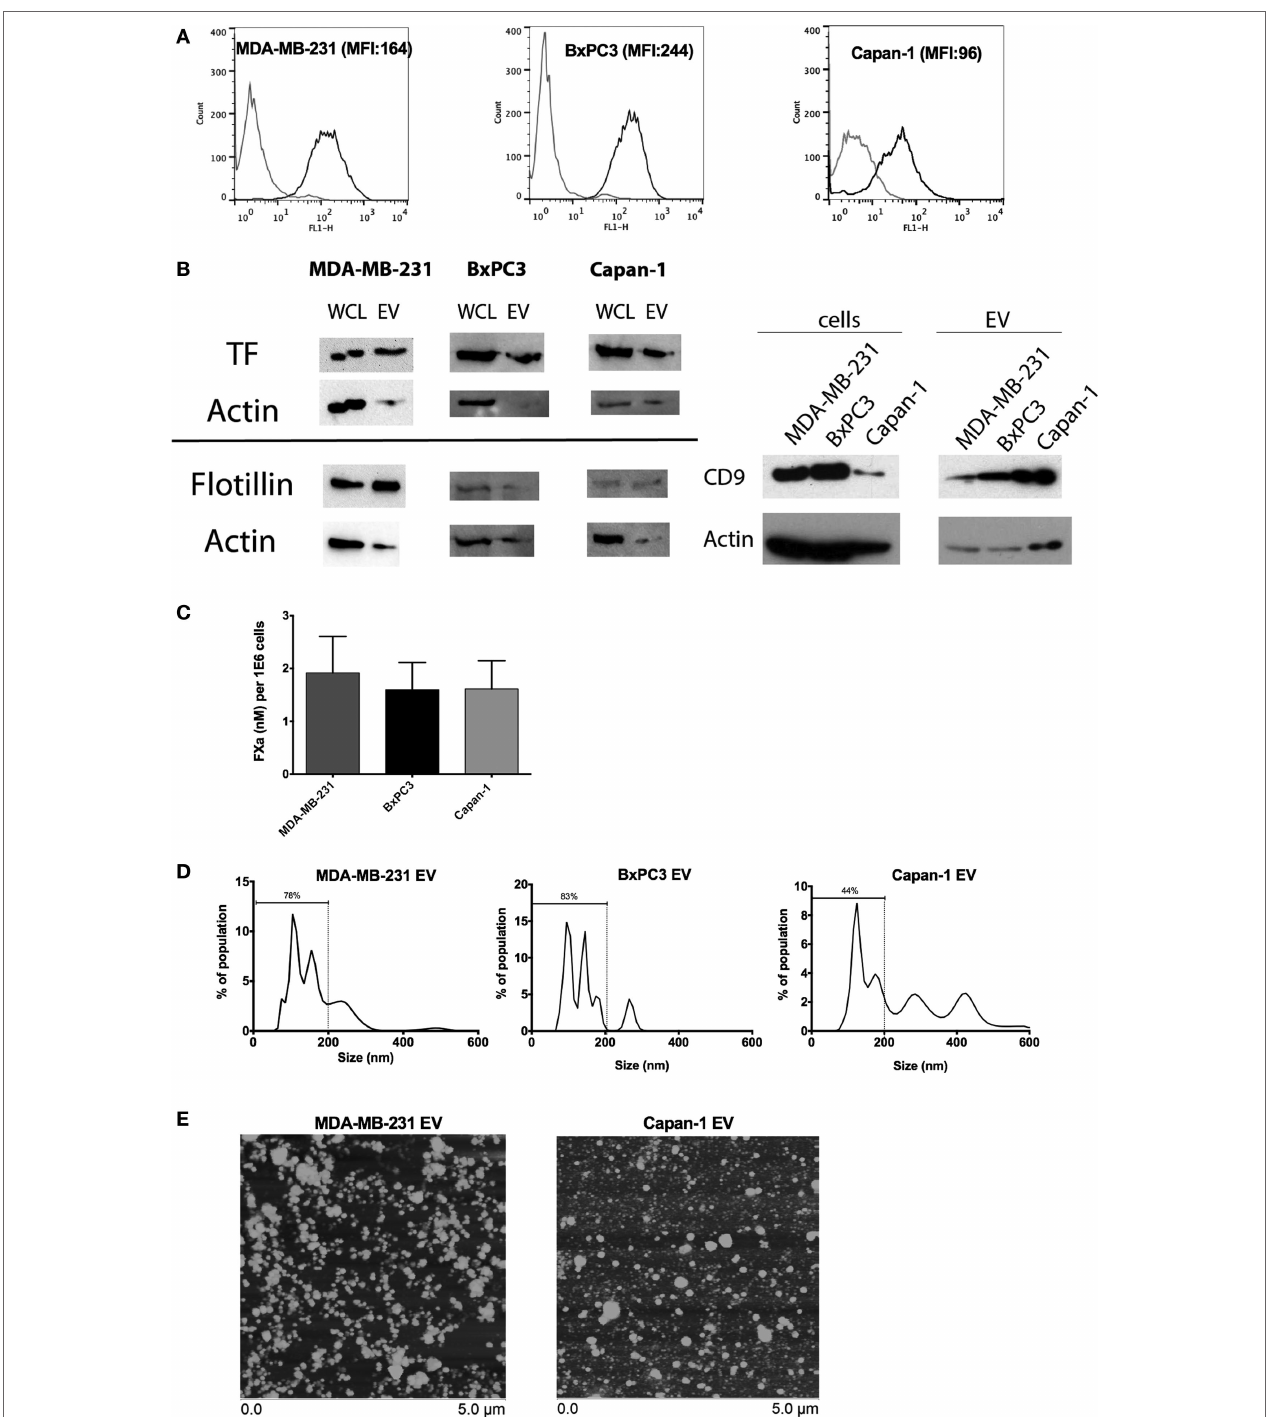
FigUre 1 | Characterization of tissue factor (TF) antigen and procoagulant activity on tumor cell lines and secreted extracellular vesicle (EV). (a) Representative histograms and mean fluorescence intensity (MFI) of surface TF antigen expression on MDA-MB-231, BxPC3, and Capan-1 as determined by flow cytometry with an antibody against TF (black line) and an isotype control (gray line). (B) TF antigen expression was determined in whole cell lysates (WCL) and EV using immunoblotting. Flotillin and CD9 were used to verify the presence of EV on separate immunoblots. Actin was used as a loading control. (c) Procoagulant activity of tumor-derived EV (normalized per million of original tumor cells) was measured using an amidolytic assay for activated factor X (FXa) activation. (D) Representative size distribution of tumor-derived EV as characterized by nanoparticle tracking analysis (NTA). All experiments were done in triplicate. (e) Atomic force microscopy showed that EV preparations from MDA-MB-231 and Capan-1 consisted of a mixture of small and large vesicles, compatible with exosomes and microvesicles. The preparations from Capan-1 contained more larger vesicles, consistent with the NTA results.